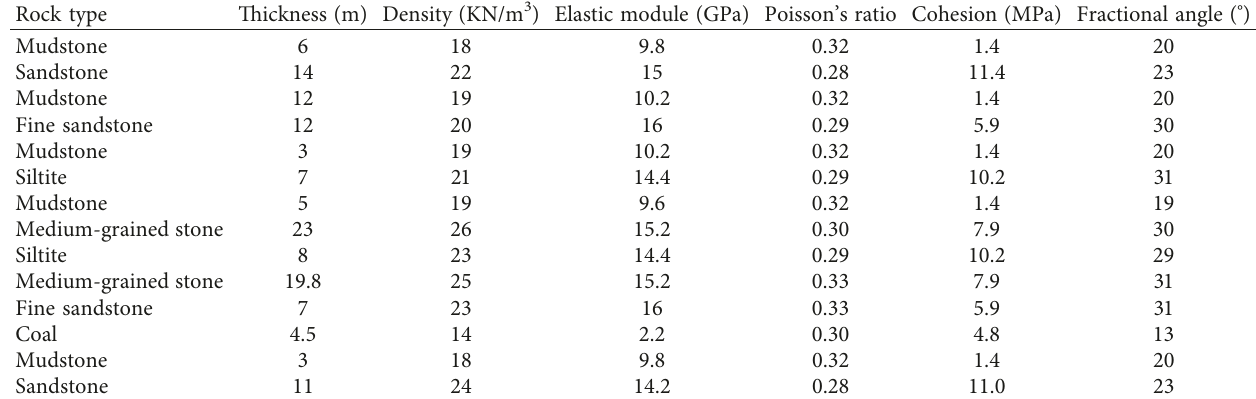
Figure 12: Lateral suspension roof shape detection hole above the coal pillar of the 11215 return airway. Table 4: Mechanical parameters of coal and rock mass in numerical model.